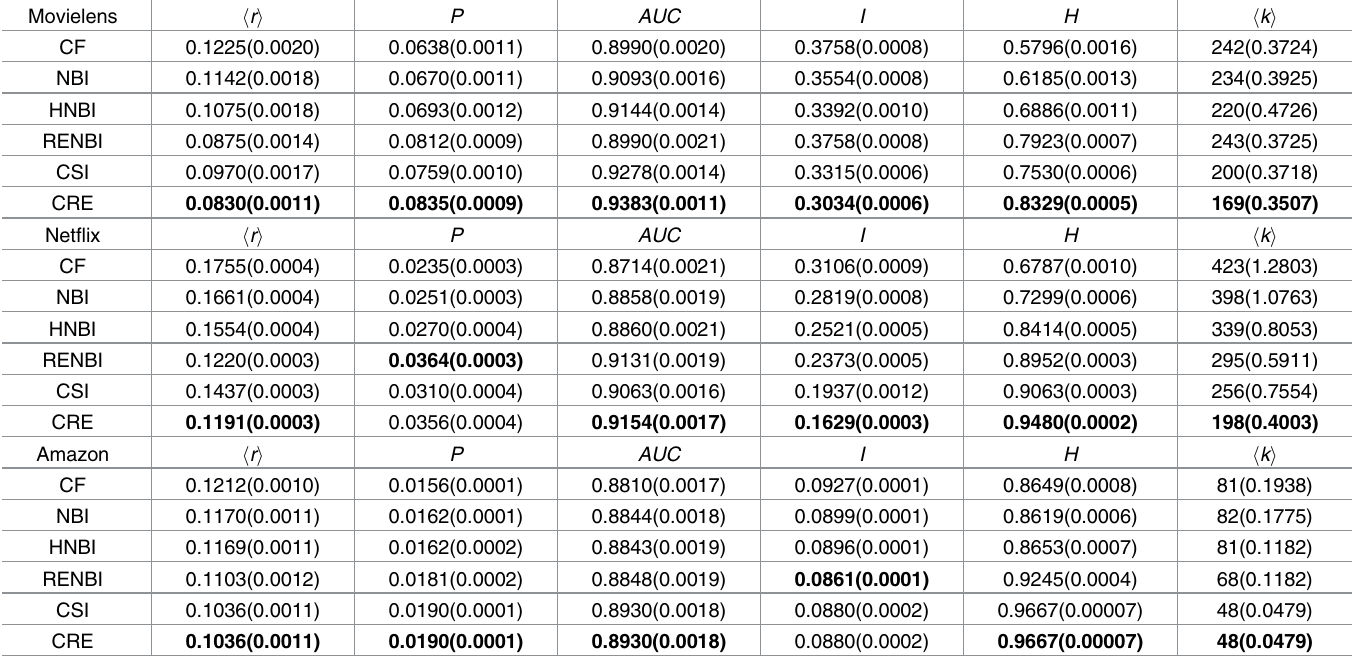
Table 1. Performancecomparison table. The optimal α ’s of ranking score h r i for HNBI, RENBI, CRE are (-0.86, -0.76, -0.93) in Movielens, (-1, -0.81, -0.88) in Netflix and (-0.08, -0.53, 0) in Amazon, respectively. And the other evaluation metrics— P for precision, AUC, I for intra-similarity, H for hammingdistance, h k i for popularity—take the values correspondingto the optimal α of h r i . The recommendation list L = 50, and the samplingnumber n in AUC is one million. All the values are obtainedby averagingover ten independent runs with different data set divisionsand numbersin brackets stand for the standard